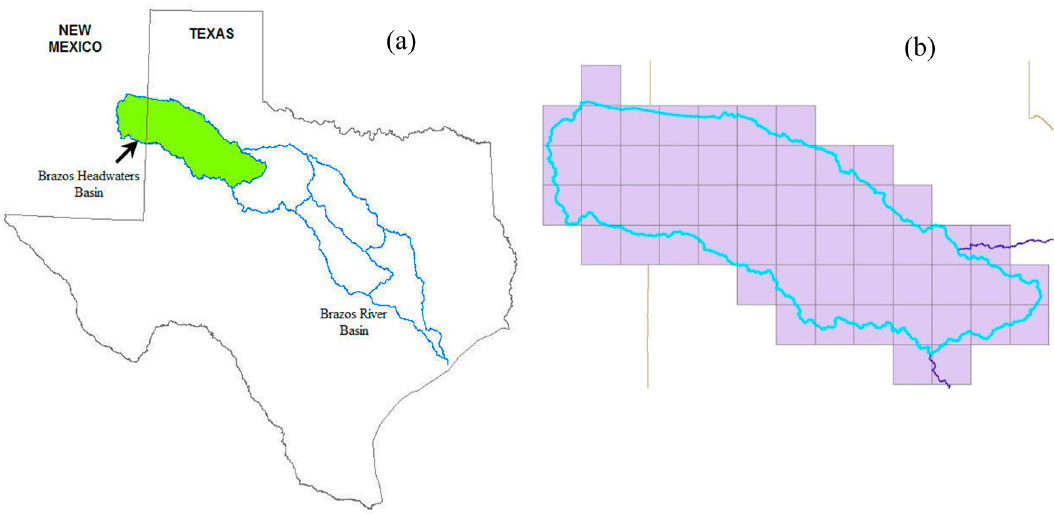
Figure 1. Map of the state of Texas with ( a ) location of the Brazos Headwaters Basin; and ( b ) NCEP ‐ CFSR grids covering the Brazos headwaters basin.